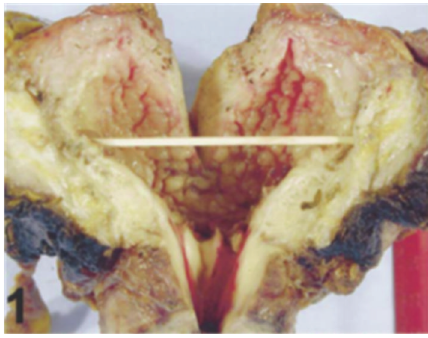
Figure 7: The nuclei of the tumor cells are relatively uniform with finely granular chromatin, inconspicuous nucleoli, and rare mitosis (Case 1) (hematoxylin-eosin, original magnification × 400) Xiao et al.